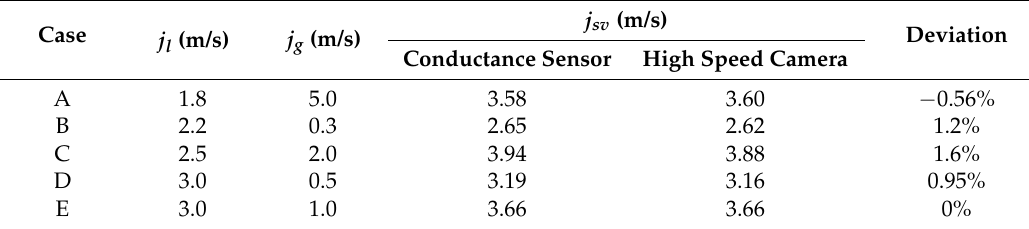
Table 6. Validation results of the structure velocities measured by the conductance sensor.